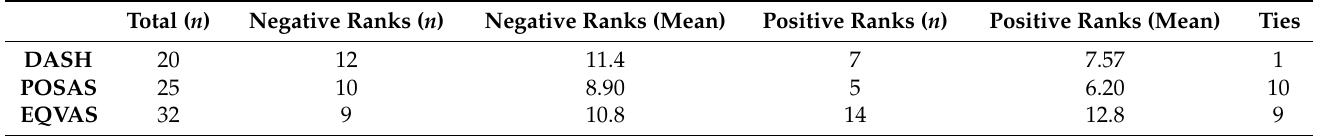
Table 3. Comparisons over